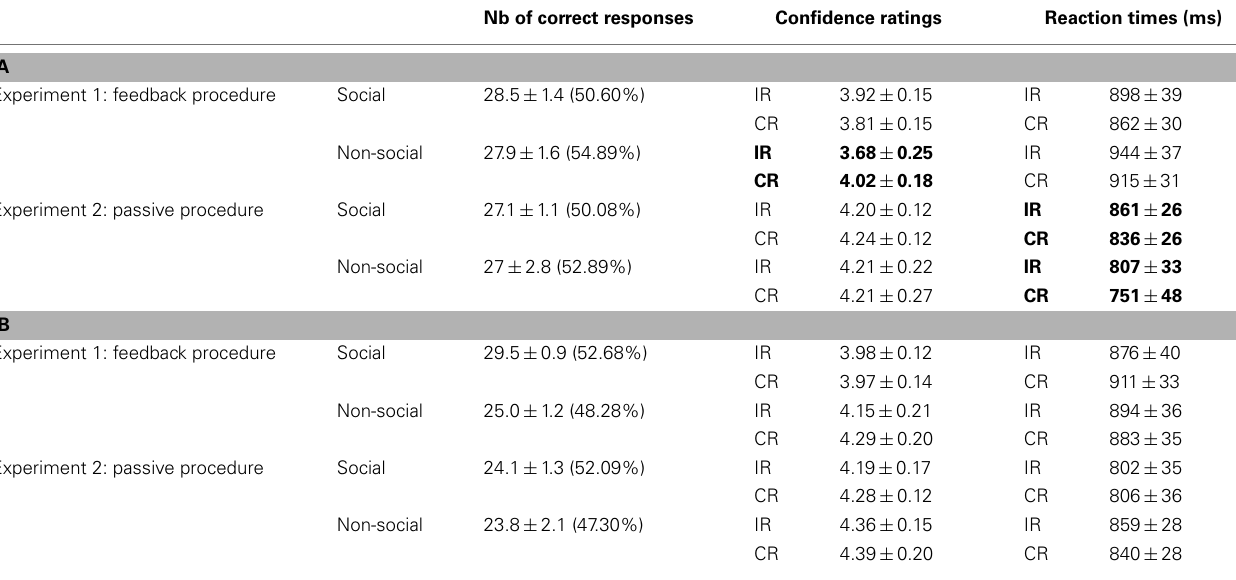
Table 1 | Results of experiment 1 and 2, for (a) post-association phase and (b) pre-association